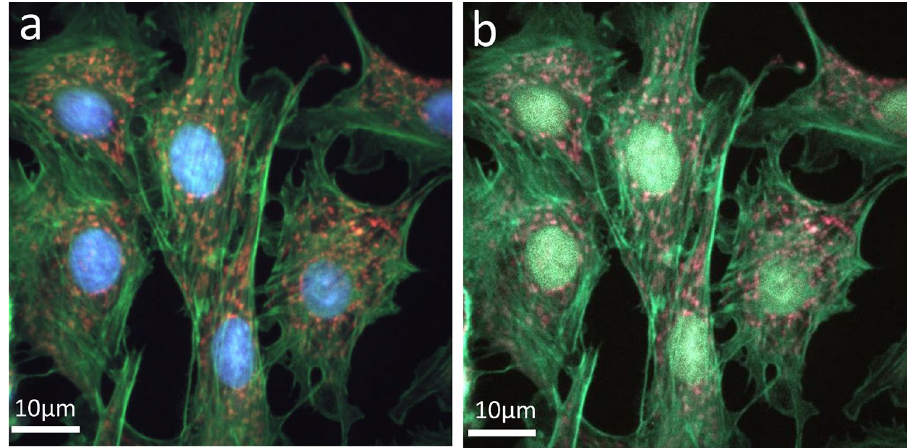
Figure 5. Synthesized fluorescence images using conventional FTS with He-Ne correction for various sampling numbers (N): ( a ) N = 1000, and ( b ) N = 50. Scale bars: 10